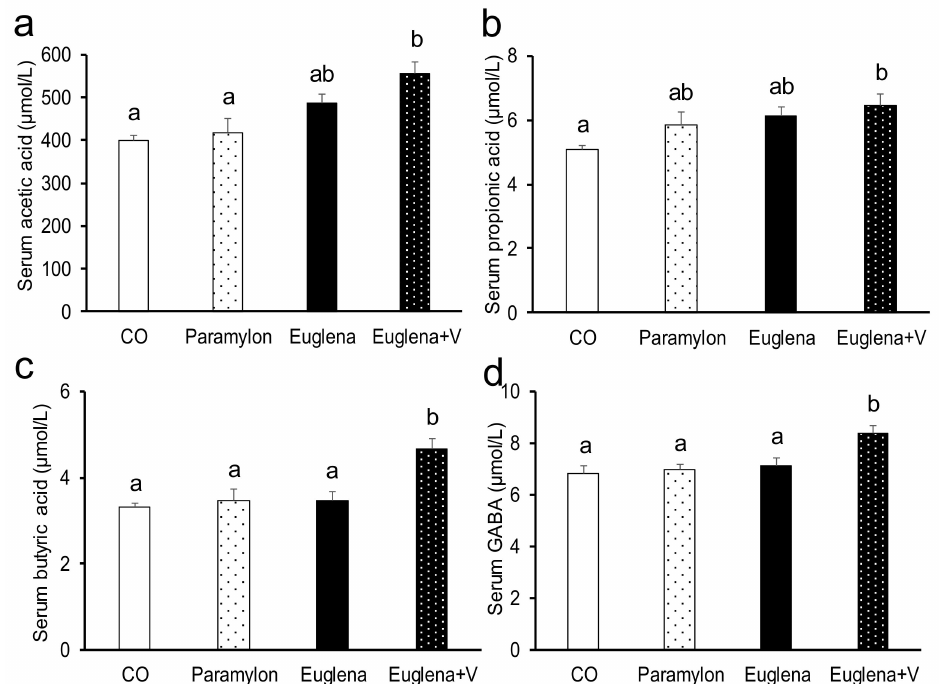
Figure 3. Effects of intake of Euglena and vegetables on SCFAs and GABA levels in serum of mice. ( a ) Serum acetic acid level, ( b ) Serum propionic acid level, ( c ) Serum butyric acid level and ( d ) Serum GABA level are presented as the mean ± standard error of the mean, n = 10. Different superscript letters indicate significantly different means at p < 0.05 (refer to “Result” in detail). CO, control diet group; Paramylon, the group that received the normal diet containing 0.3% paramylon; Euglena, the group that received the normal diet containing 1.0% Euglena; Euglena + V, the group that received the normal diet containing 1.0% Euglena and 0.3%